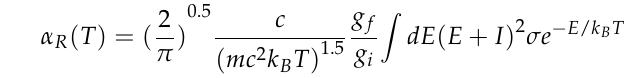
Table 6. Recombination rate coefficients (cm 3 /s) for (1s1s) state of H − , He, and Li + . A comparison with R-matrix results (interpolated) is also indicated.